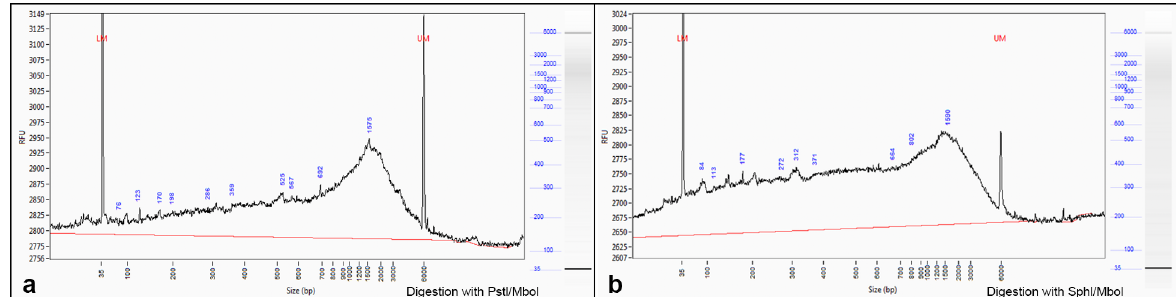
Figure 2. In vitro digestions profiles of S. coryne genomic DNA. Fragment Analyzer system runs. (a). Digestion with PstI/MboI and (b). Digestion with